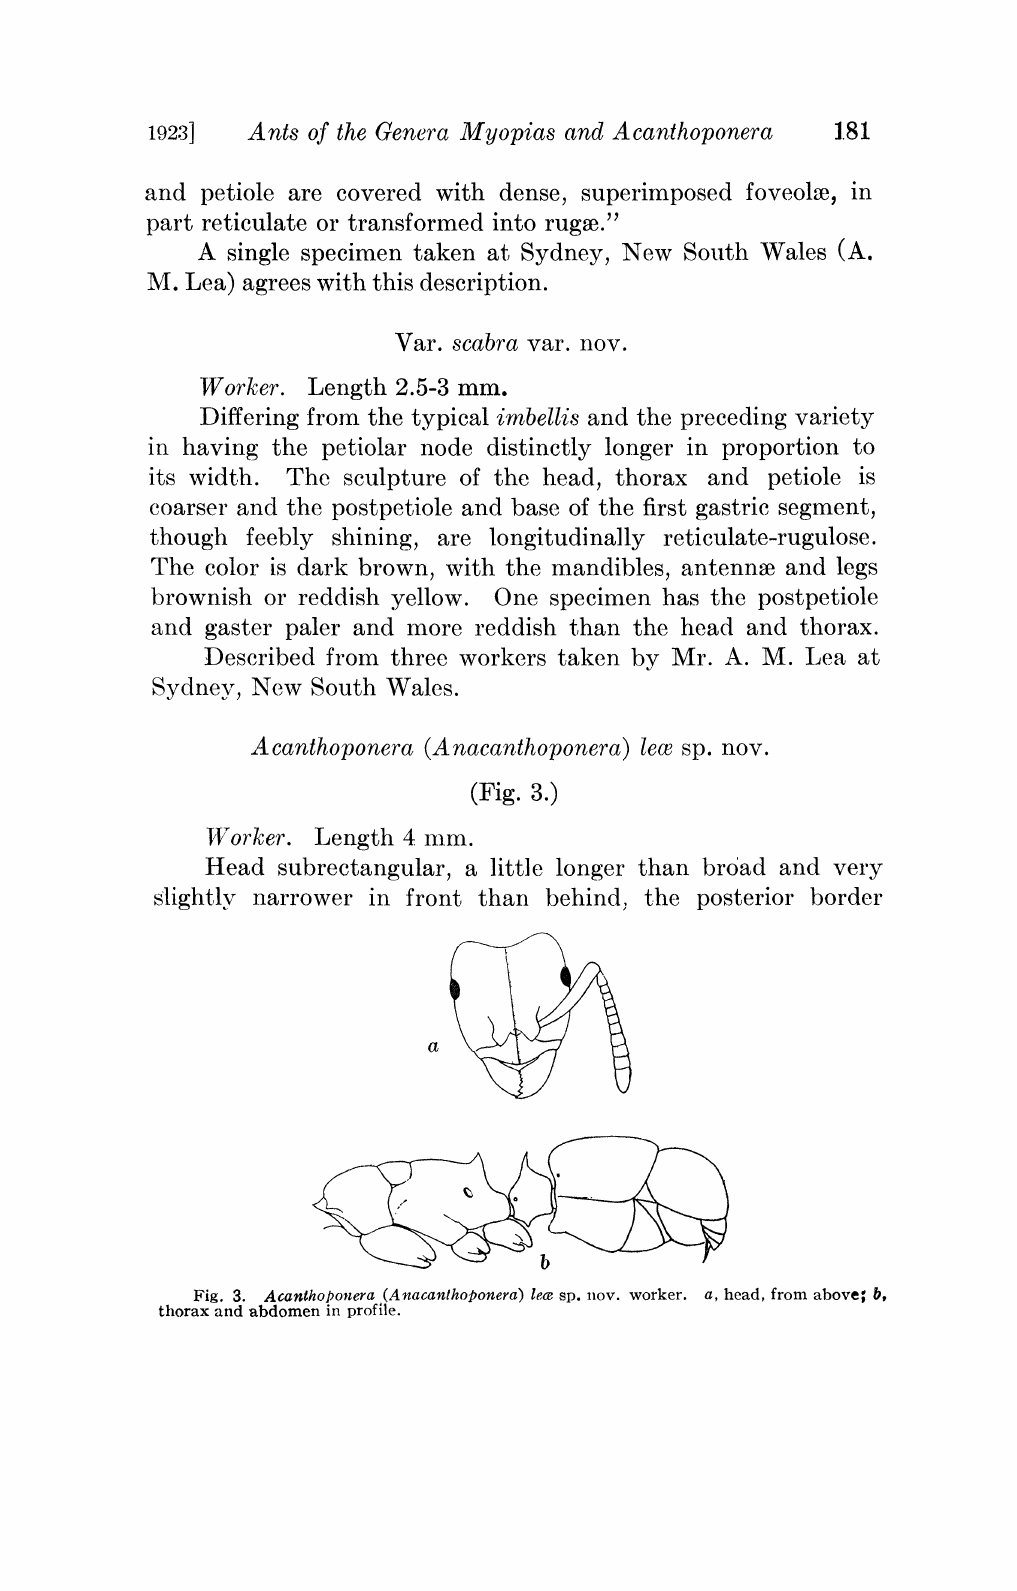
Fig. 3. Aeanthoponera (Anacanthoponera) le6e sp. worker, a, head, from above b, thorax and abdomen in